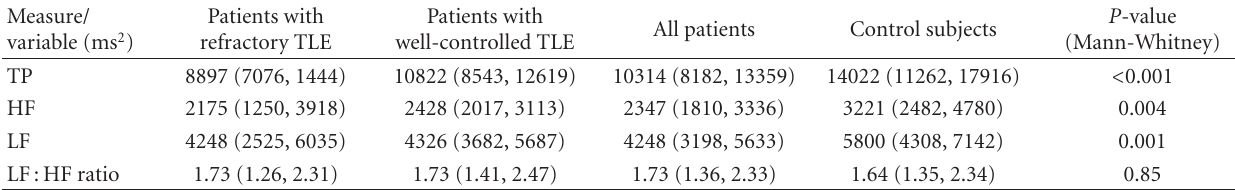
Table 3: Heart rate variation during head-up tilt in patients with temporal lobe epilepsy (TLE) and the control subjects. The P -value presents the di ff erences between all patients and the control